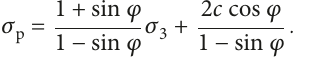
Figure 3: Elastic modulus of sandstone specimens under a natural state with various con fi ning